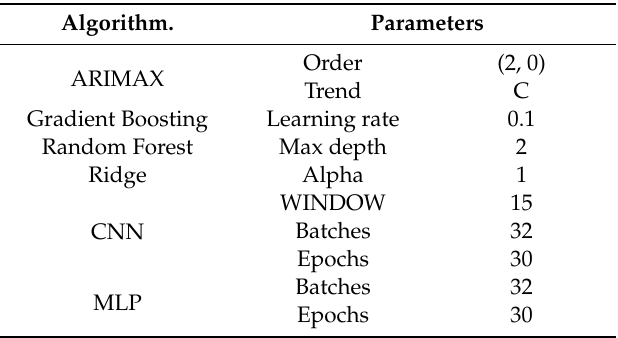
Table 8. Hyperparameter settings of the competing methods. Algorithm.